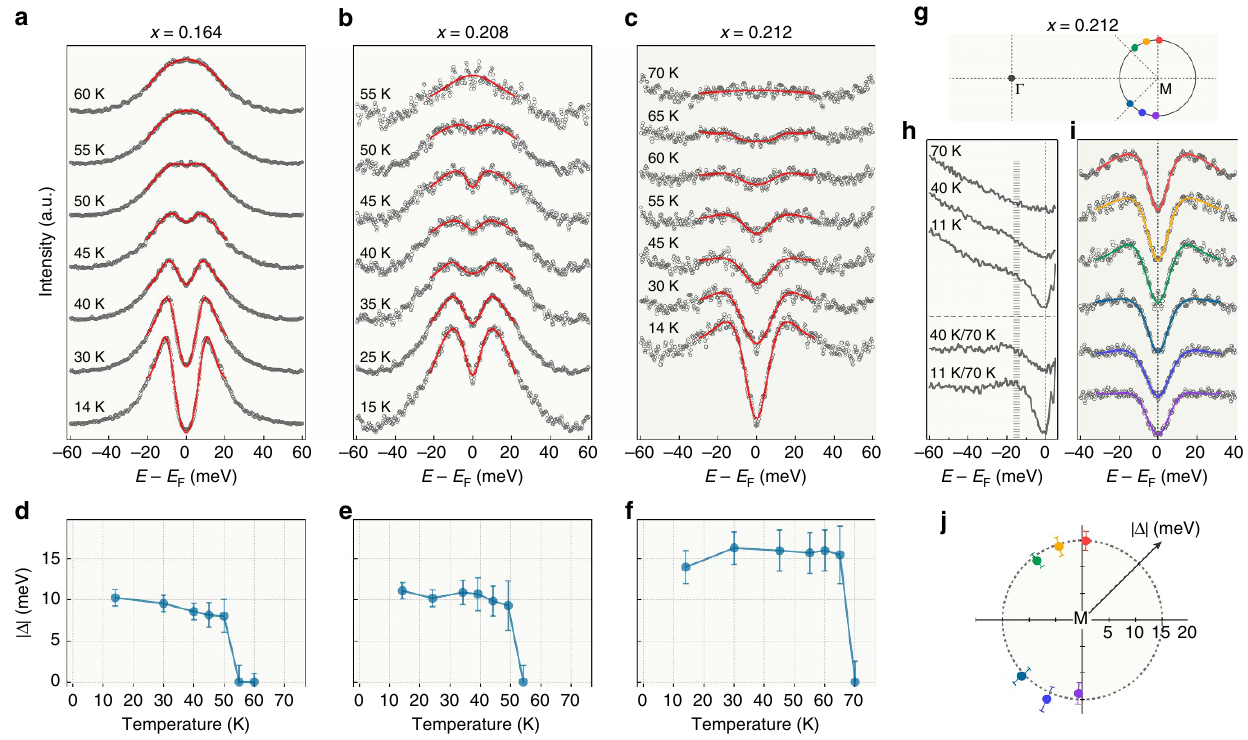
Figure 3 | Superconducting gap. ( a – c ) Temperature evolution of the symmetrized EDCs at the k F point of the electron FS around M for pristine and potassium-coated 1UC FeSe/STO. The electron doping is indicated above the panels. The red curves correspond to fit of the data. ( d – f ) Superconducting gap sizes as a function of temperature obtained from the fits shown in a – c , respectively. Error bars are estimated from the standard deviation (s.d.) of the fitting. ( g ) Schematic FS of K-coated 1UC FeSe/STO with doping x B 0.212. ( h ) Upper part: temperature evolution of the EDCs at G divided by the FD function. Lower part: low temperature EDCs further divided by the one at 70K. ( i ) Symmetrized EDCs at 14K measured at various k F points as indicated by coloured dots in g . ( j ) Polar representation of the momentum dependence of the superconducting gap size for the electron FS around M. Error bars again are estimated from s.d. of the fitting. A nearly isotropic gap is highlighted by the dashed grey circle at